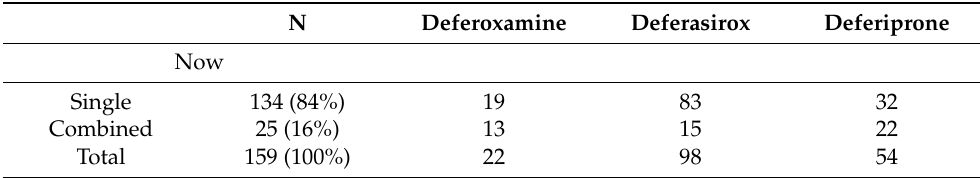
Table 3. Distribution of iron chelation therapy.